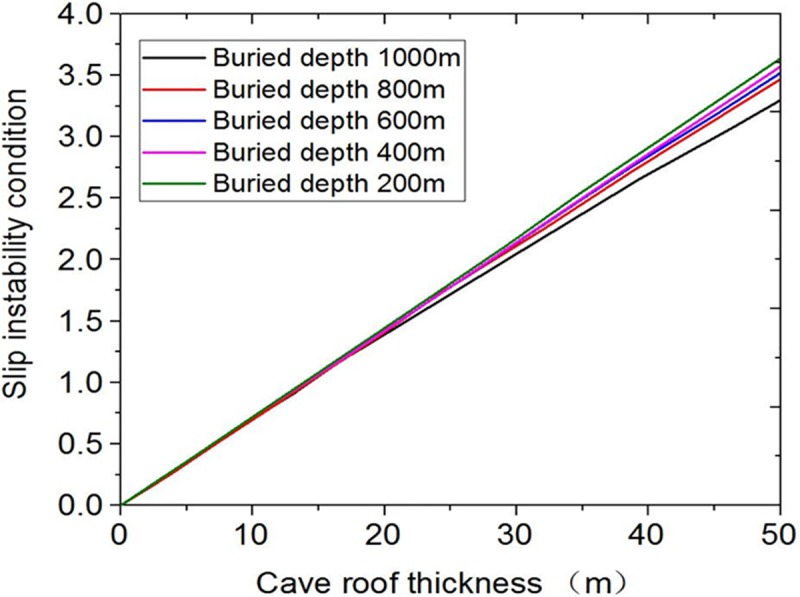
Influence curves of different buried depths.